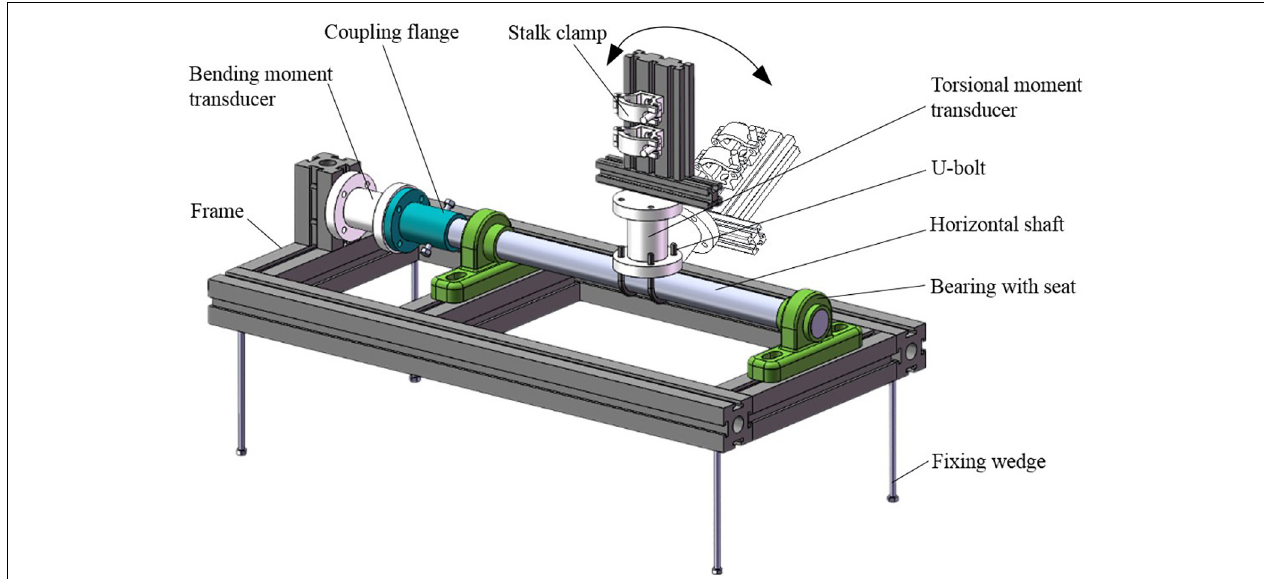
FIGURE 5 | Structural diagram of the mounting